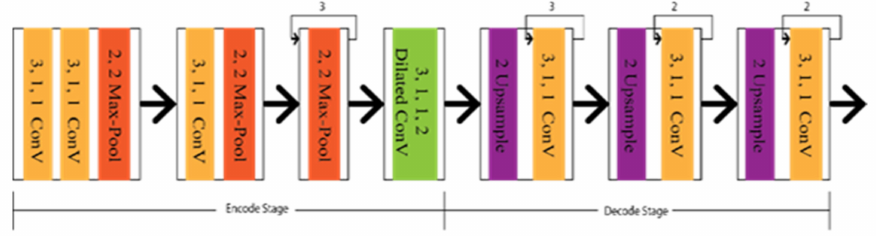
Figure 6. Schematic diagram of Deep Convolution Neural Network based on the lane markings detector